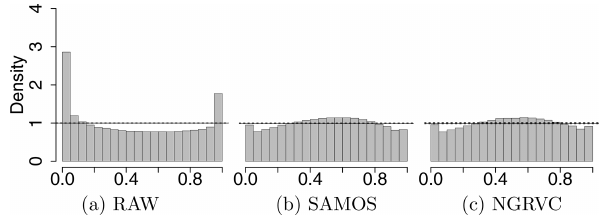
Figure 3. PIT histograms of the probability distributions of the raw ensemble (a) and the ensemble postprocessed with SAMOS (b) and the NGRVC (c) for all stations combined. Solid horizontal lines show perfect calibration and the dotted lines are the 95% consis- tency interval thereof.